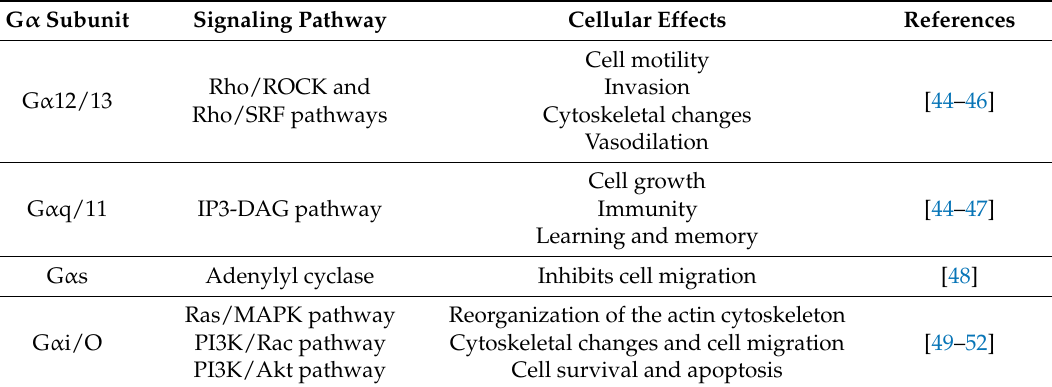
Table 1. Lysophosphatidic acid (LPA)-receptor mediated G α signaling and its cellular effects. G α Subunit